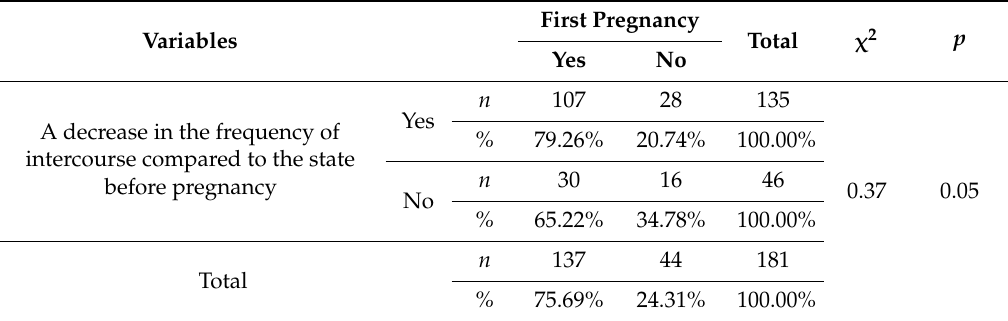
Table 11. Relationship between being pregnant for the first time and reducing the frequency of intercourse compared to the state before pregnancy. First Pregnancy Variables